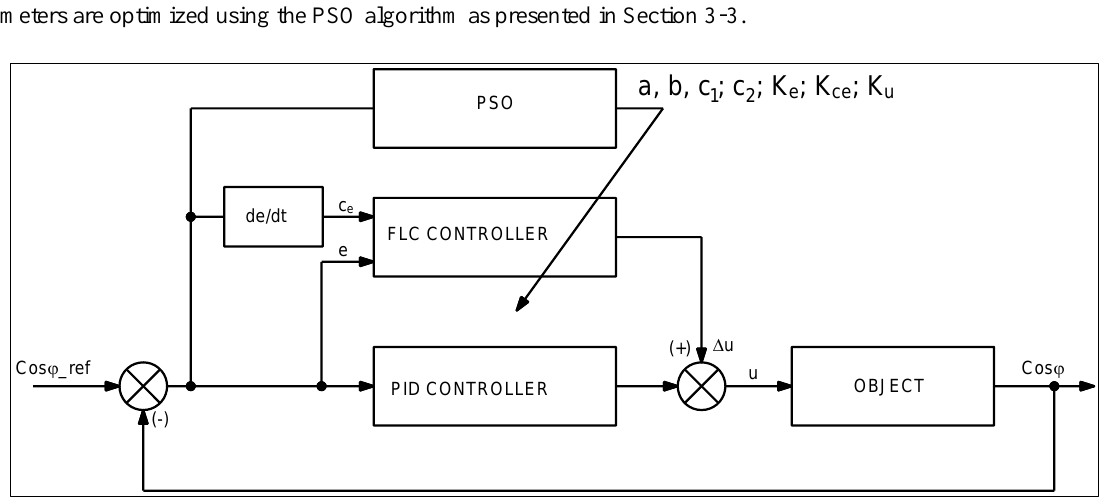
Figure 13. PSO-based hybrid PID-FLC Sugeno controller